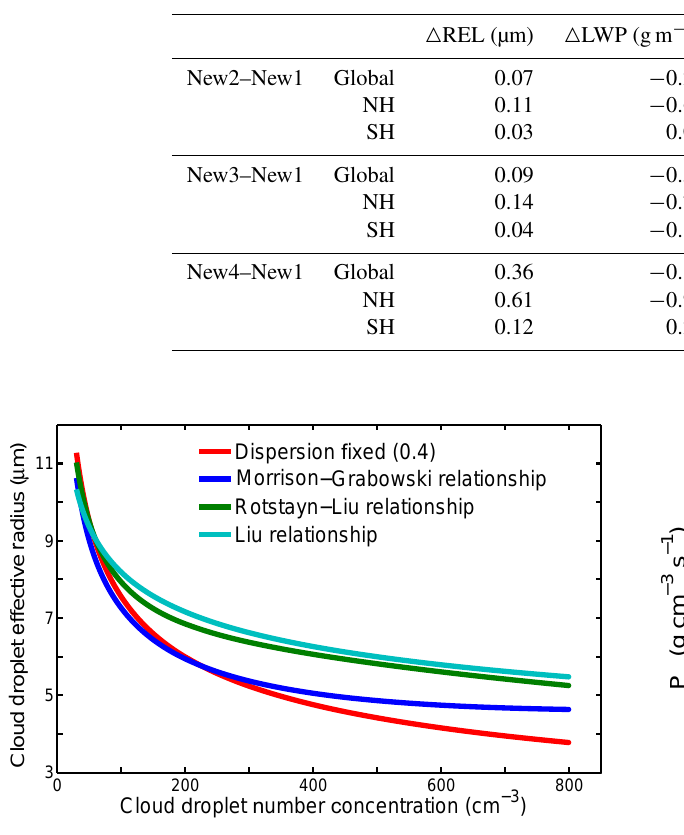
Figure 5. Variations in the cloud droplet effective radius as the func- tions of droplet concentration for relative dispersion fixed at 0.4 (red curve), the Morrison–Grabowski relationship (blue curve), the Rotstayn–Liu relationship (green curve), and the Liu relationship with fixed liquid water content L c as 0.12gm − 3 (cyan curve).